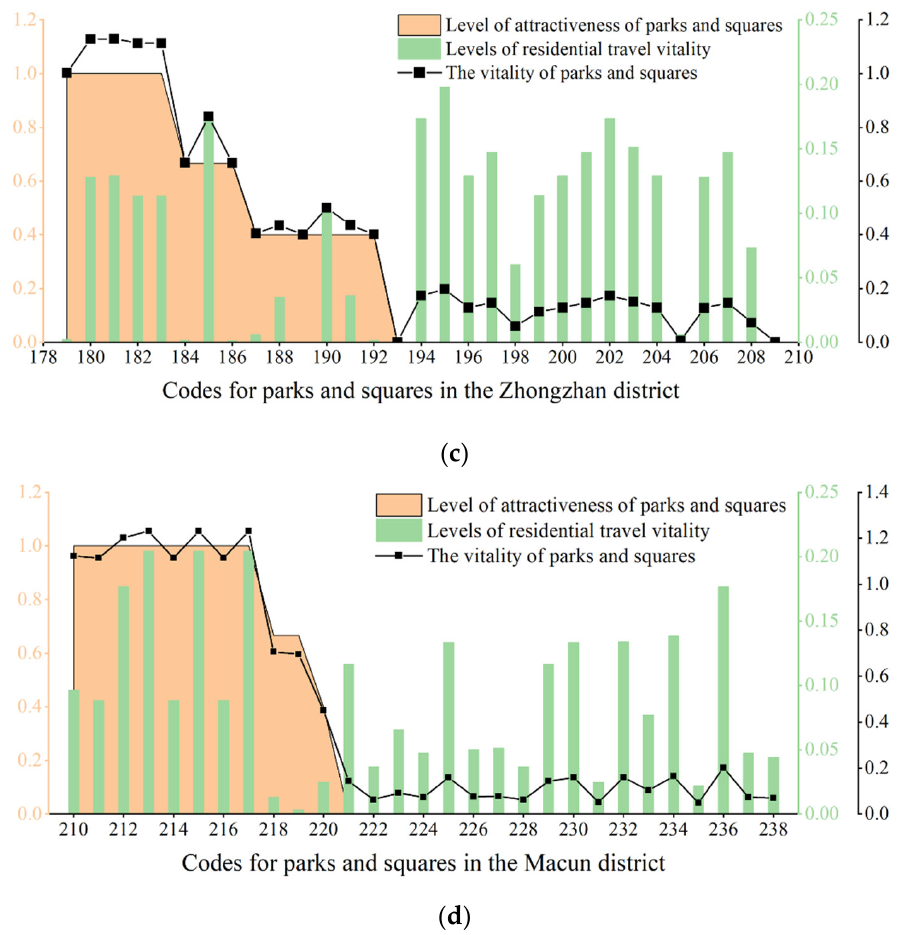
Figure 12. The vitality of parks and squares in the four districts of the main urban area in Jiaozuo: ( a ) the vitality of parks and squares in Jiefang District; ( b ) the vitality of parks and squares in Shanyang District; ( c ) the vitality of parks and squares in Zhongzhan District; ( d ) the vitality of parks and squares in Macun District.